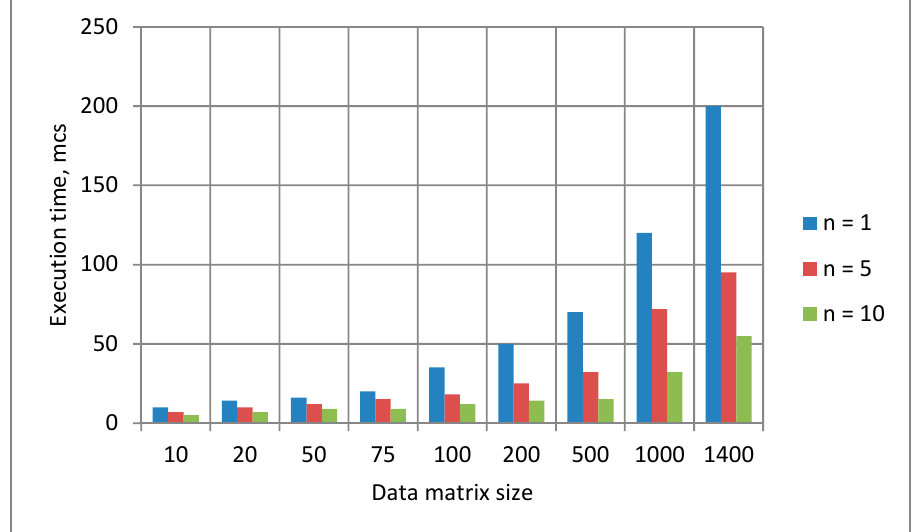
Figure 11. Dependence of execution time for the Funk SVD on the number of nodes exchanging the optimal decomposition parameter.